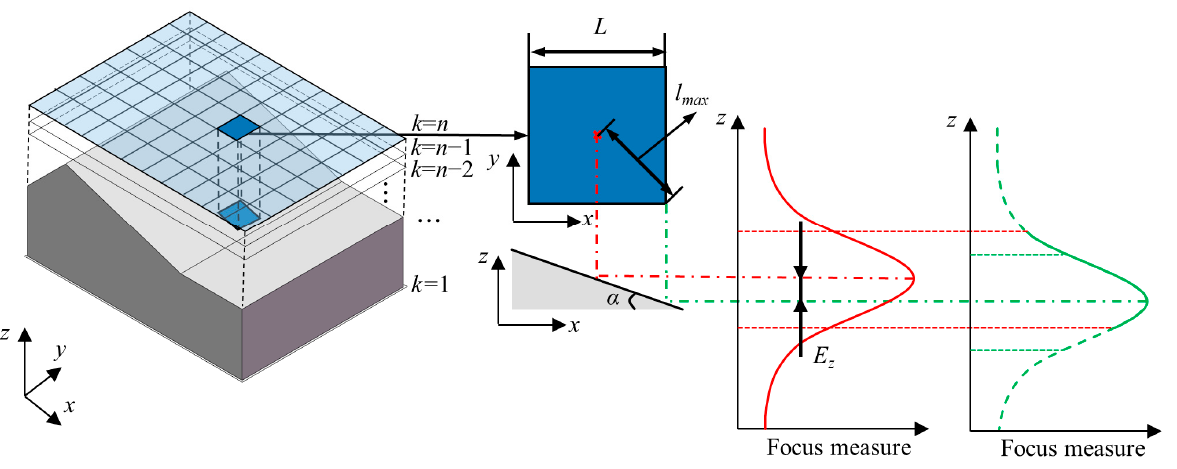
Figure 5. Approximate focus measure interval.